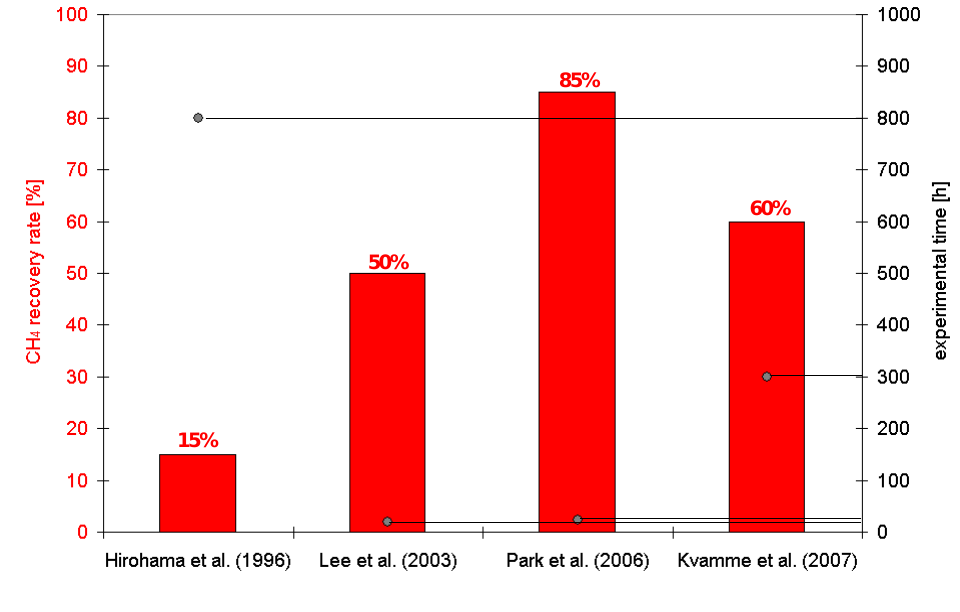
Figure 1. Four examples from literature showing varying CH induced by CO injection after a certain amount of time. More details regarding the 2 experimental conditions are given in the